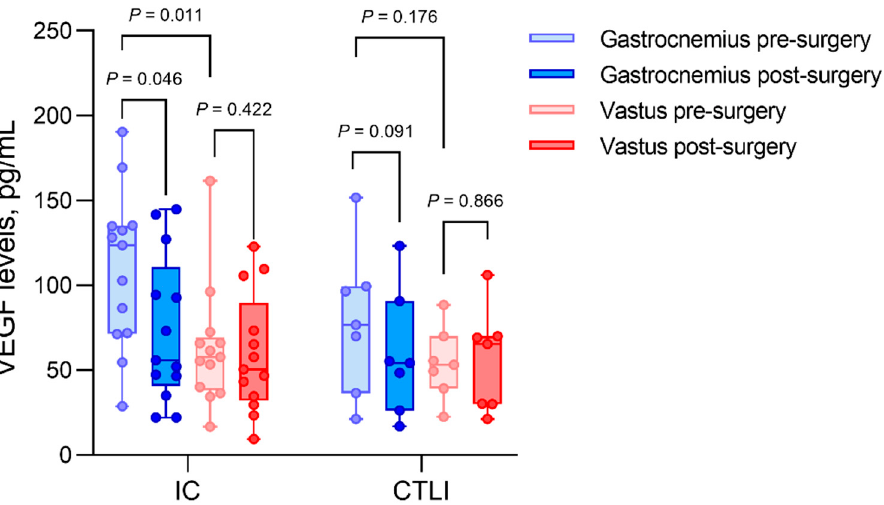
Figure 2. Intramuscular VEGF concentrations of patients with intermittent claudication (IC) com- pared to critical limb ischemia (CLTI) in gastrocnemius and vastus lateralis muscle biopsies, before (pre) and after (post) revascularization. Gastrocnemius muscles are considered ischemic, and vastus muscles are considered as non-ischemic controls.